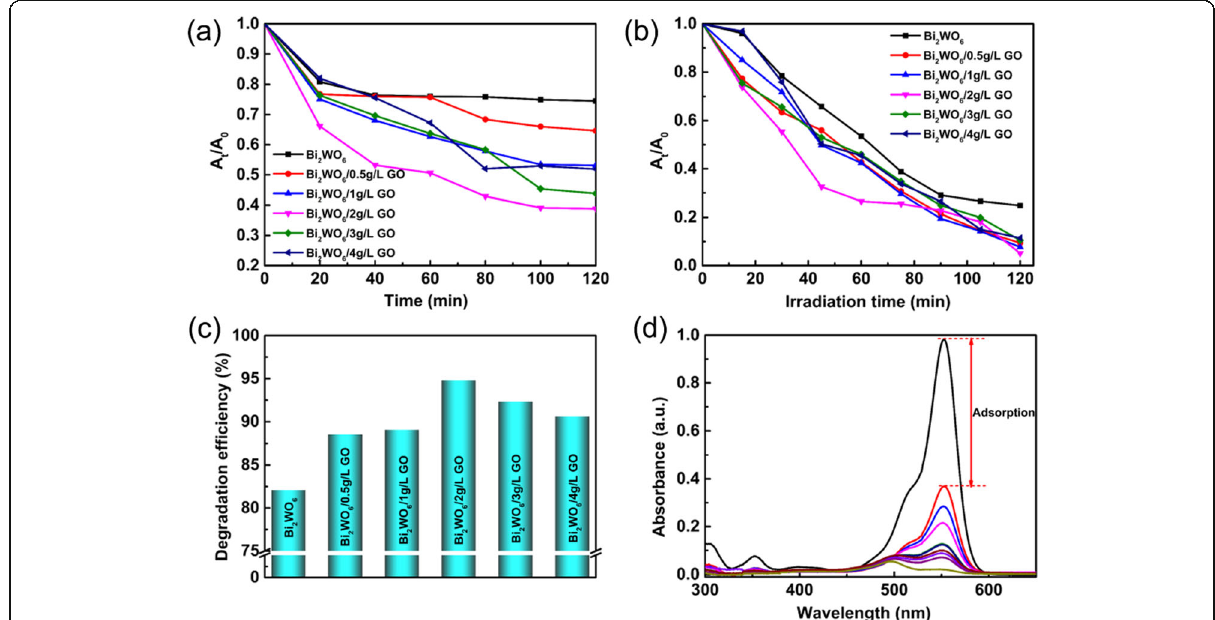
Fig. 7 ( a ) Adsorption of RhB over different samples in the dark; ( b ) Absorbance of different samples for RhB under visible light irradiation; ( c ) Degradation efficiency of RhB over different samples and ( d ) UV-Vis absorption spectra of RhB by Bi 2 WO 6 /2 g/L GO deposited PET